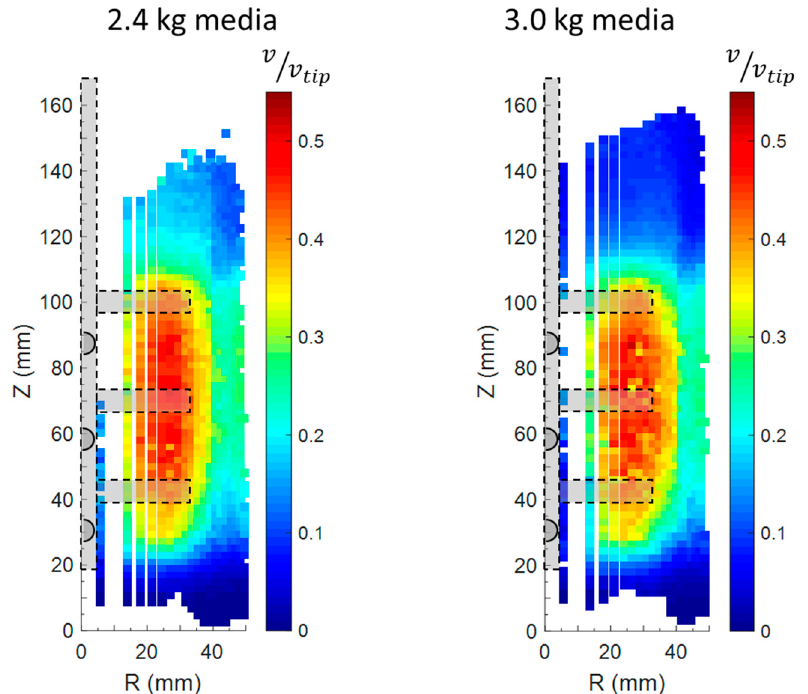
Figure 11. PEPT dimensionless velocity magnitude ( v / v tip ) for two bead loading: 2.4 kg and 3.0 kg of media. Test case using the clearance of 19 mm and the impeller speed of 600 rpm.